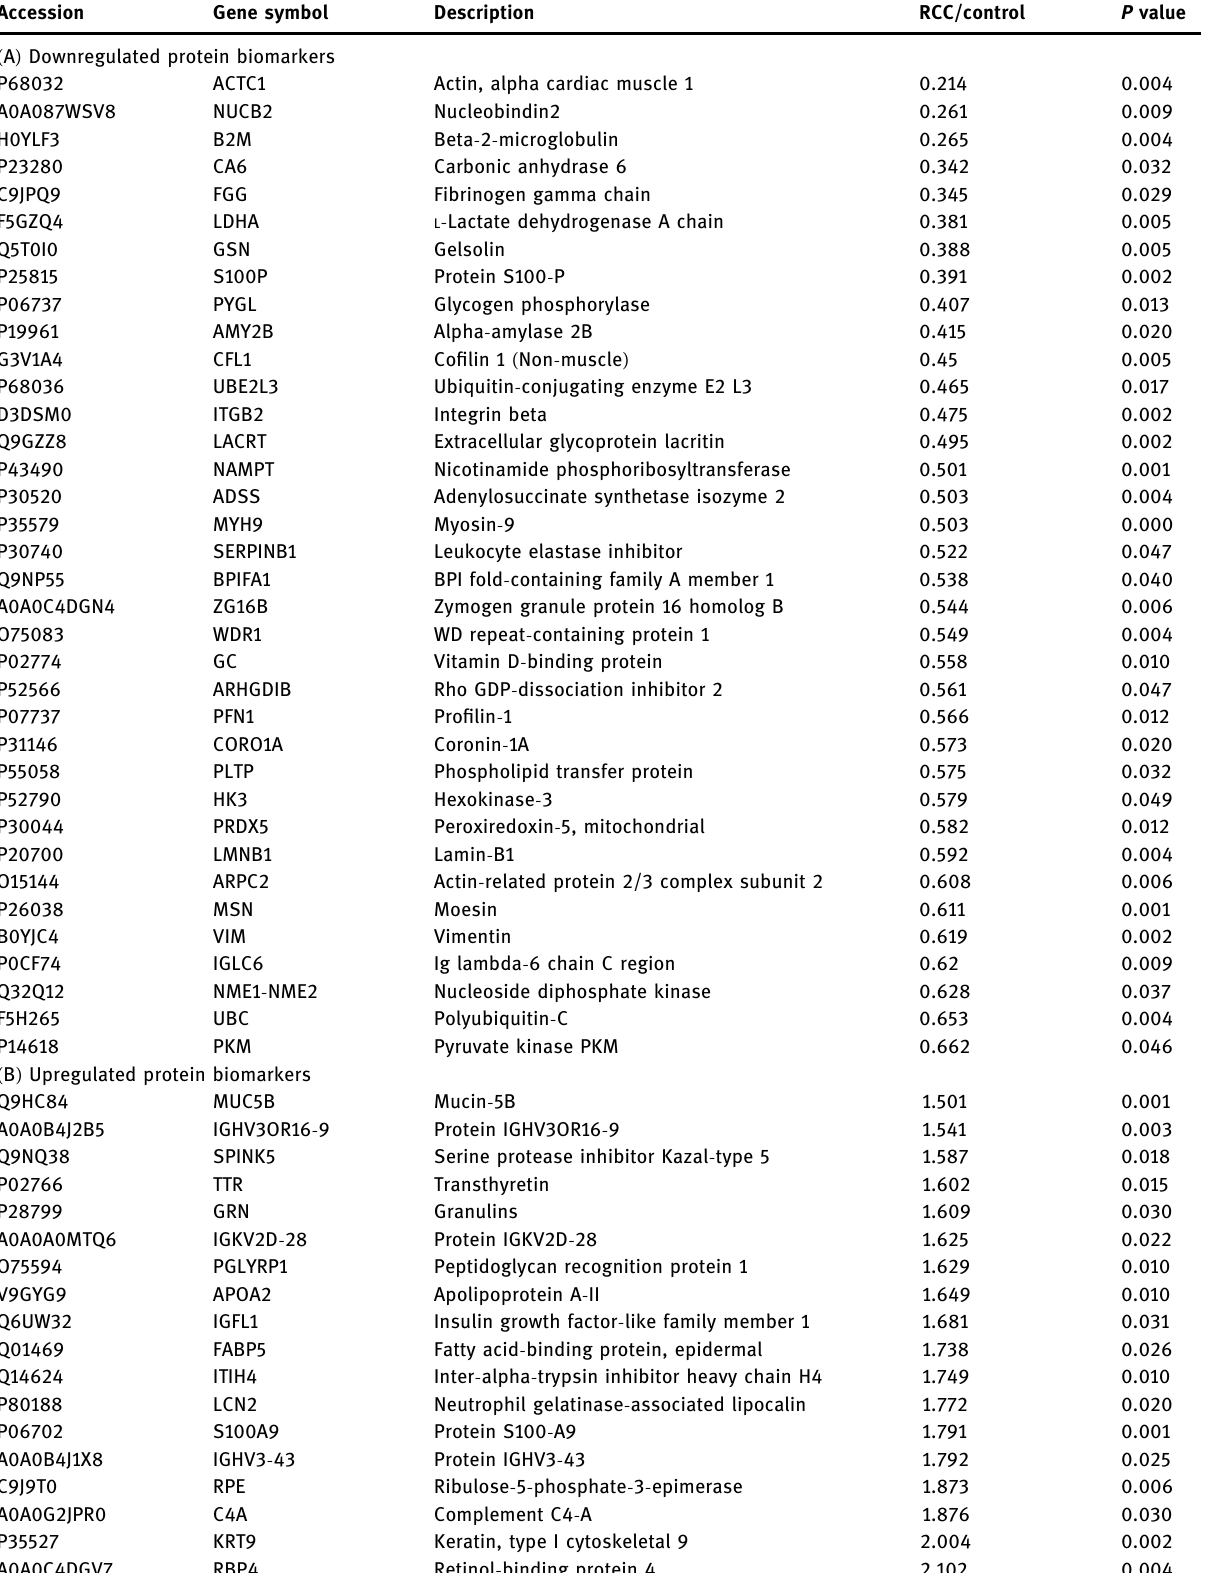
Table 2: Salivary protein biomarker